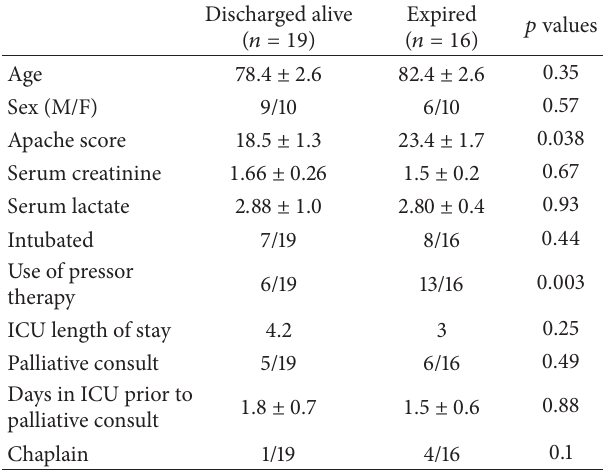
Table 1: Demographics and outcome of patients who were DNRand then admitted to an ICU.